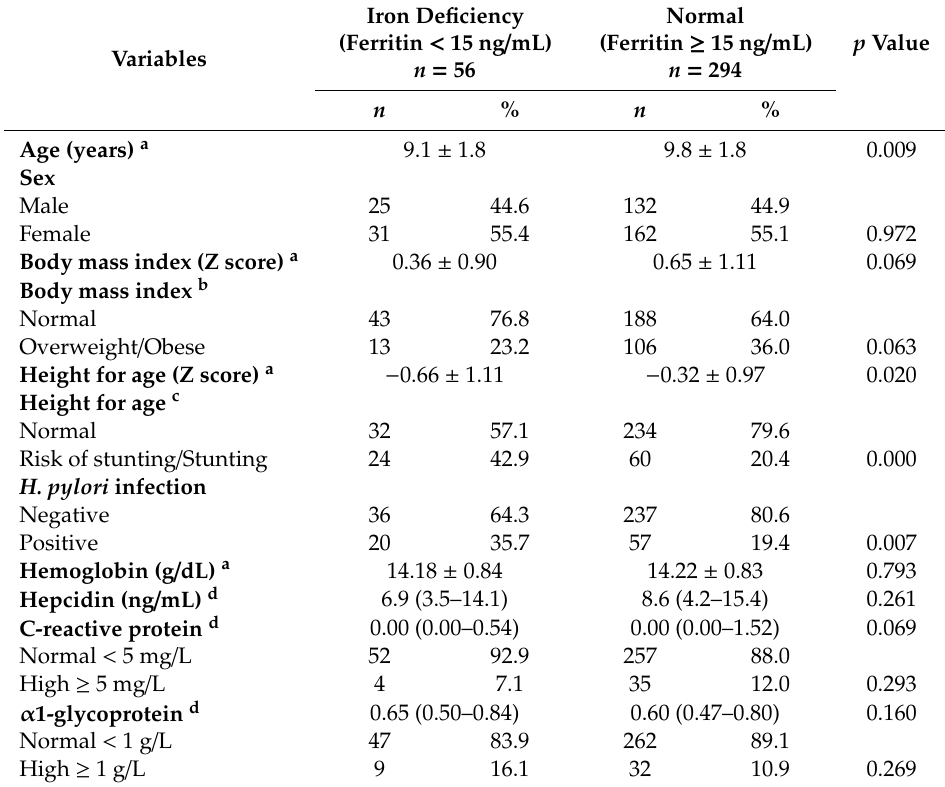
Table 1. Characteristics of the study population by iron nutritional